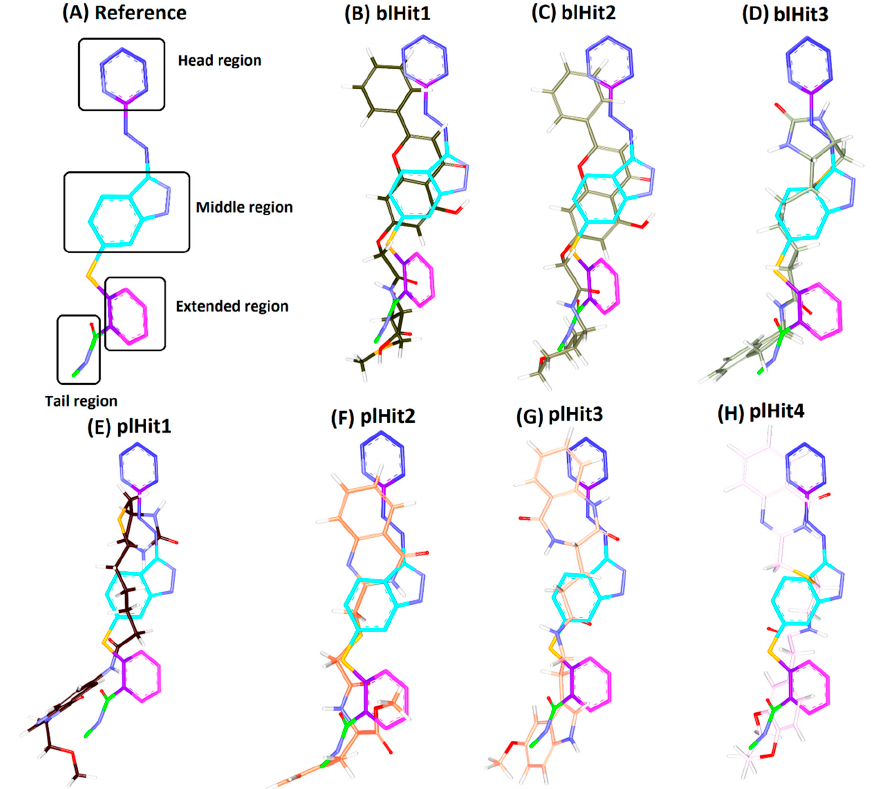
Figure 6. Elucidating the structural activity relationship (SAR). Different colours encoding the regions representing the reference compound. The identified compounds are represented by defined colours. ( A ) Different groups of the reference compound that occupy the active site; Figures ( B – H ) demonstrates the structural alignment of the identified compounds with the reference compound. (B) Alignment of blHit1 and the reference; ( C ) Overlay of reference and blHit2; ( D ) Alignment of reference and blHit3; ( E ) Alignment of reference and plHit1; ( F ) Alignment of reference and plHit2; ( G ) Alignment of reference and plHit3; ( H ) Alignment of reference and plHit4.